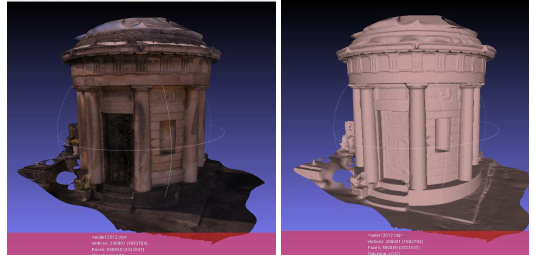
images in dataset, due obstacles. For metric accuracy test we used horizontal and vertical cross sections compared with Ground Control Points (GCP) carried out by a reliable direct survey . Therefore, 123D Catch model was scaled and referred metric accuracy evaluation considering two significant horizontal cross-sections: one at 0.75 and the other 1.50 m. Except for the areas where 3D reconstruction is not confirming what previously tested.